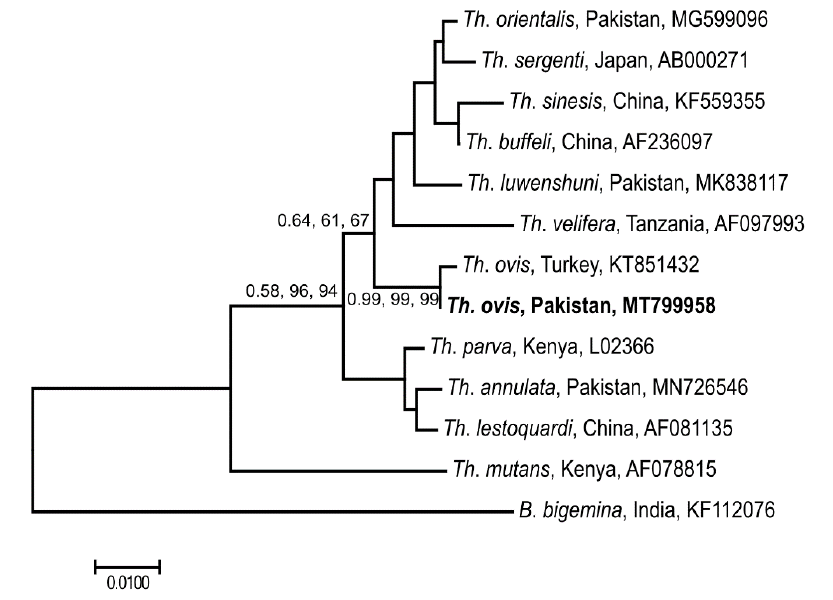
Figure 6. Phylogenetic relationship of 18S sequences of Theileria spp. from ticks of small ruminants in the FATA of Pakistan. Phylogenies were inferred using Neighbor Joining (NJ, this tree), Maximum Likelihood (ML) and Bayesian Inference (BI) methods. Sequences determined herein are shown in bold. The country of origin and GenBank accession numbers for each sequence are also provided. Nodal support values are presented as a posterior probability for BI (left) followed by bootstrap values for ML and NJ. The scale-bar indicates the number of inferred substitutions per site.